Question: Draft a figure caption describing what is shown.
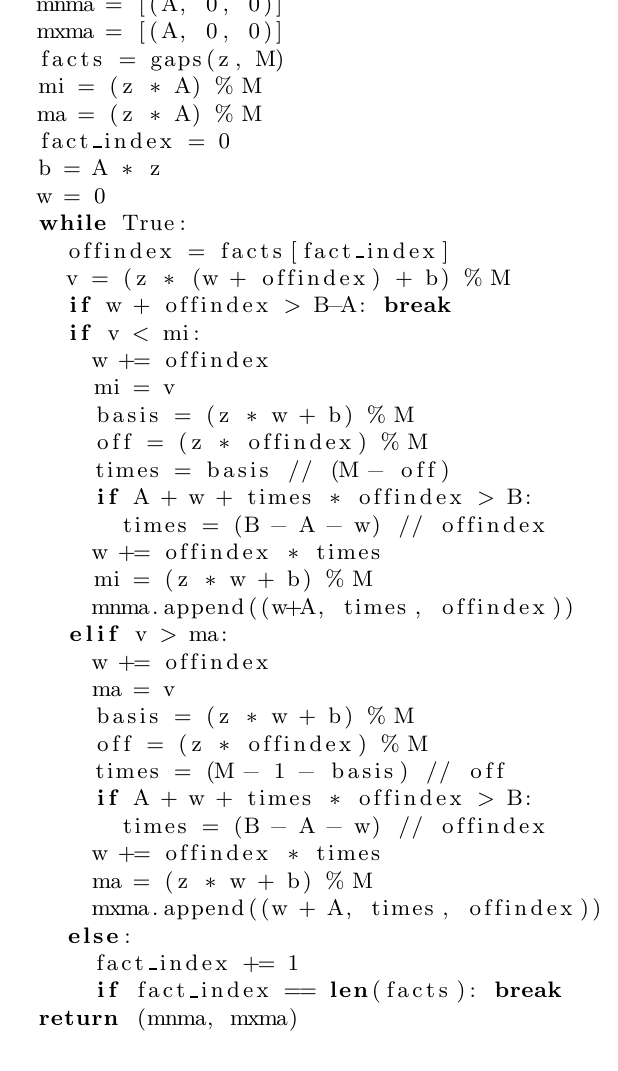
Answer: Python code to enumerate all extrema of (w × z) % M for w = A, . . . , B. M and z should be positive integers, and z should not be a multiple of M.